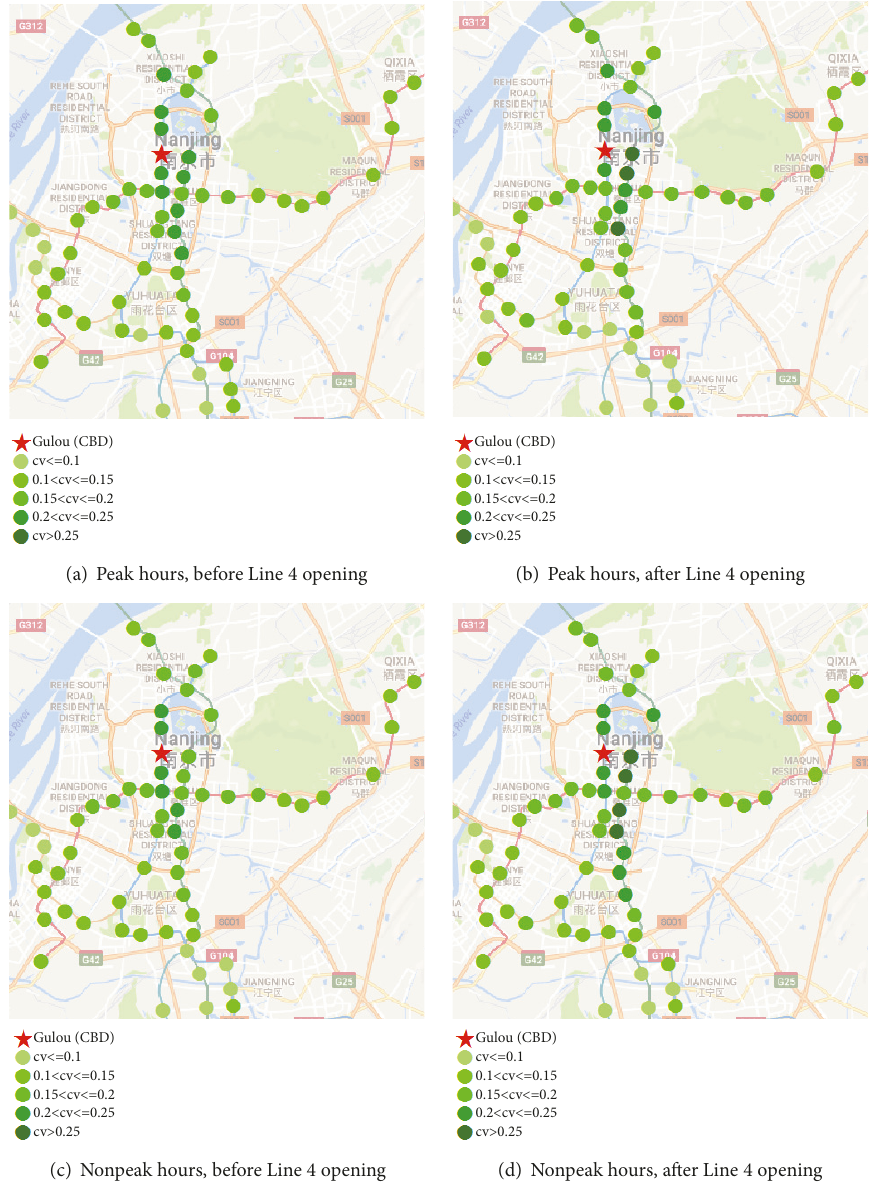
Figure 7: Travel time reliability from metro stations to CBD (map source: Google